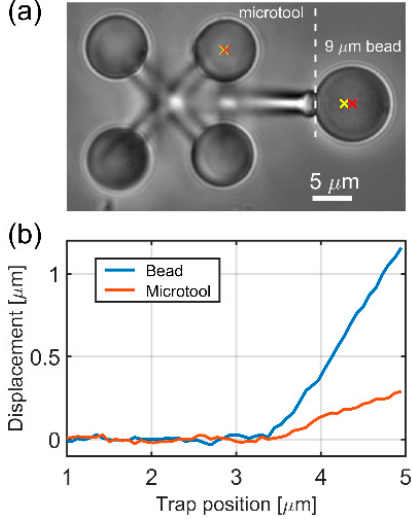
Figure 3. Trap stiffness calibration for the cell indenter microtool. Panel ( a ) shows the optical microscopic image of the tool ( left ) and the 9 μ m bead ( right ) during the calibration experiment. The yellow crosses show the positions of two optical traps, one holding one of the spheroids of the microtool, the other holding the 9 μ m bead. The red crosses show the center of one of the spheroids on the microtool and that of the bead. The distance of the yellow and red crosses gives the displacement values plotted on ( b ).